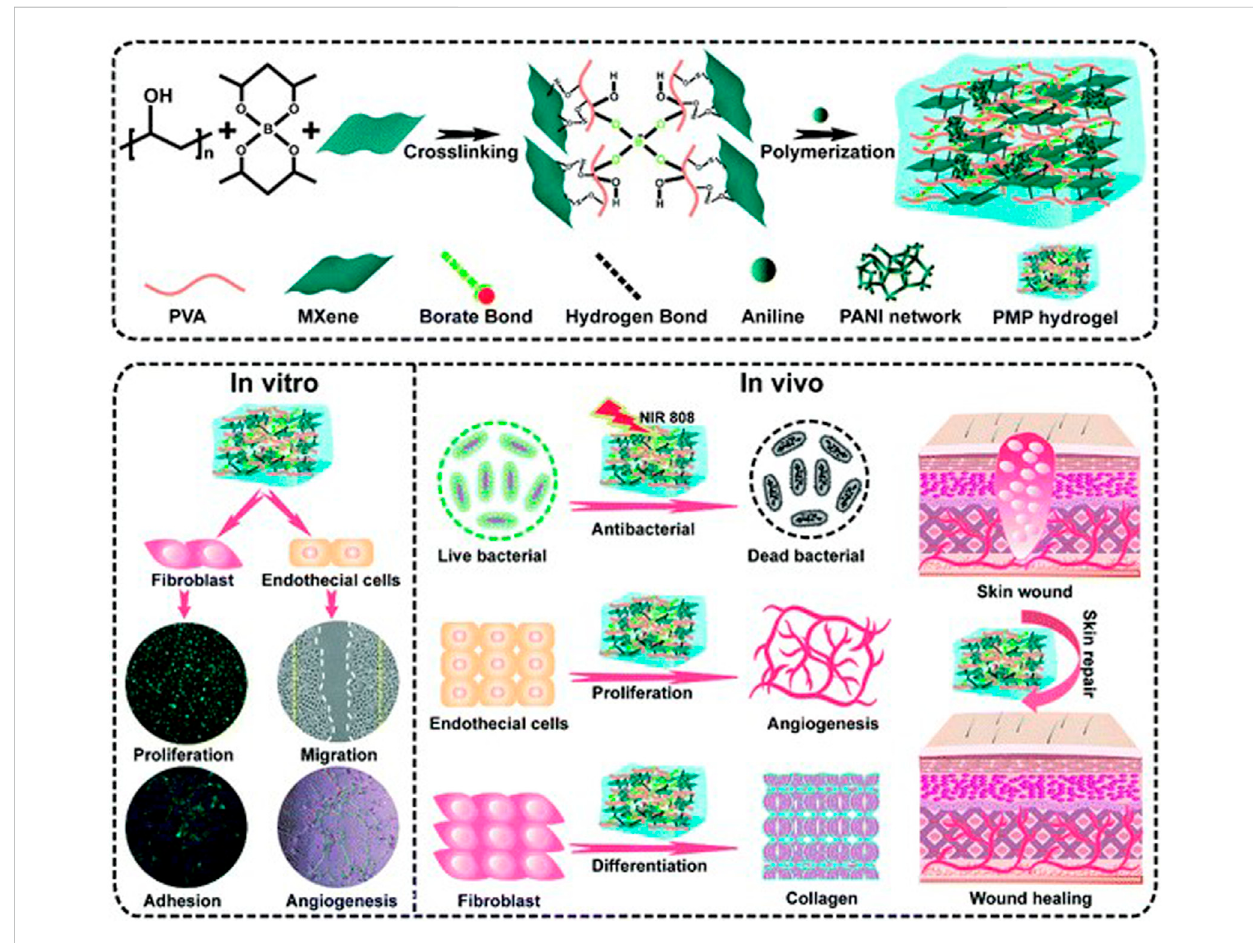
Schematic illustration of the fabrication of MXene-modi fi ed PMP hydrogels and their application in skin wound healing (Liu et al.,